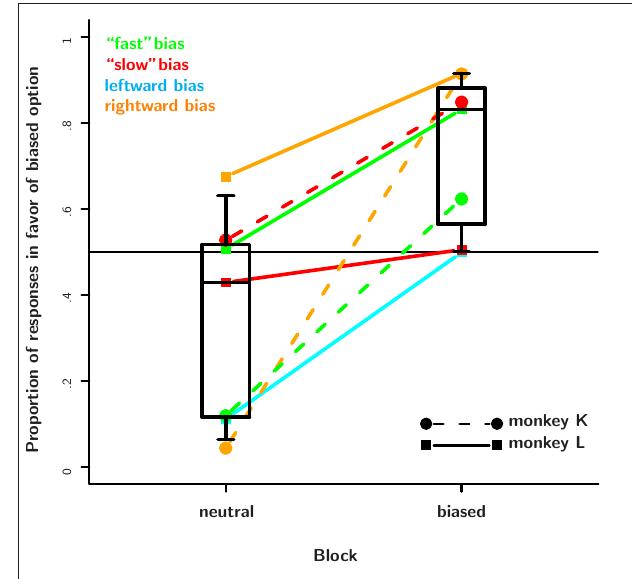
Figure 6 | Decision criteria as a function of time from the introduction of the biased reward schedule. For each speed we calculated moving averages of percent “fast” choices as a function of time from the onset of the biased reward schedule. The moving average was calculated with a box-car kernel of ± 25 trials. We fit a psychometric function to the data from each time-point in the moving average. Here we show the time-resolved PSE of the fitted functions. For both monkeys in both bias conditions, the decision criteria start moving in the predicted direction immediately after the introduction of the biased reward schedule. They reach a reasonably stable level after about 200 trials. Note that the graph averages over all trials of a given monkey and condition. Hence, a single line comprises data of e.g., the “fast” and “slow” category bias regardless of the reward asymmetry used on that particular day (4 versus 2 or 4 versus 3, or 3 versus 2 valve openings). These different conditions are balanced only for the first 600 trials.